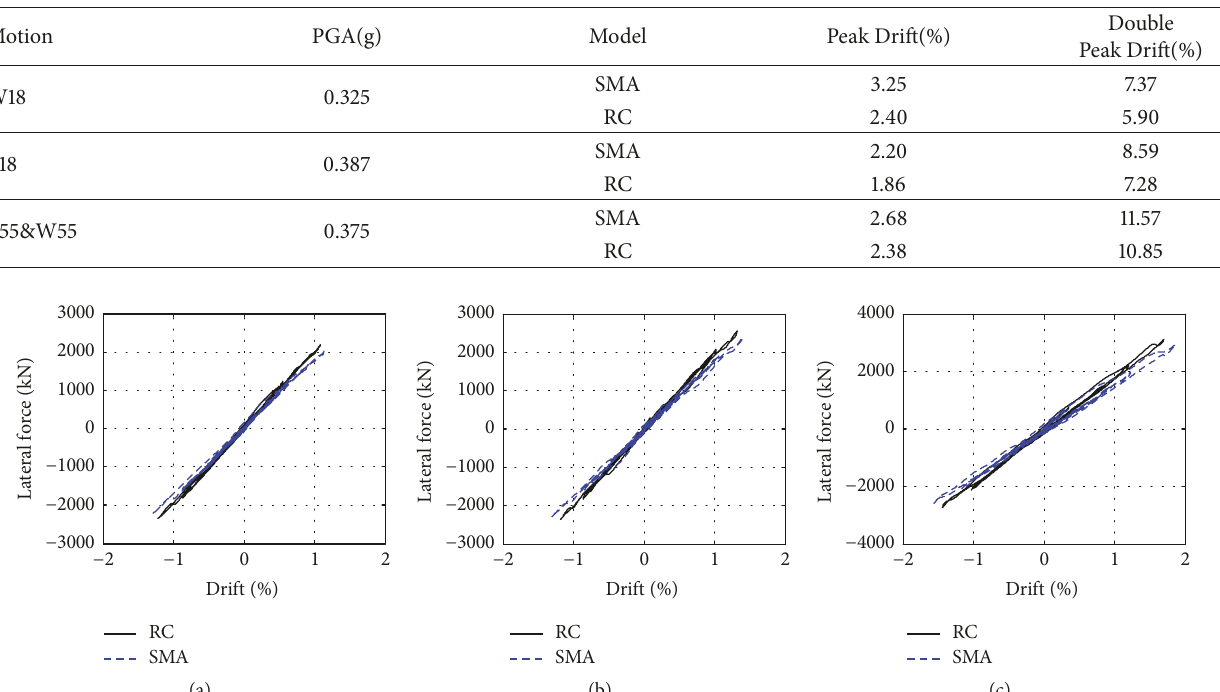
Table 2: Results in the longitudinal direction under uniform excitation.